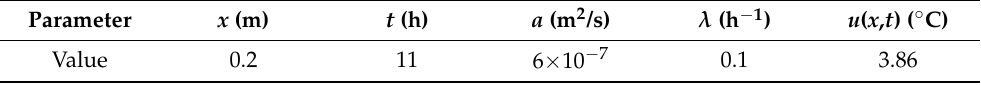
Table 2. Initial value of each parameter chosen for sensitivity